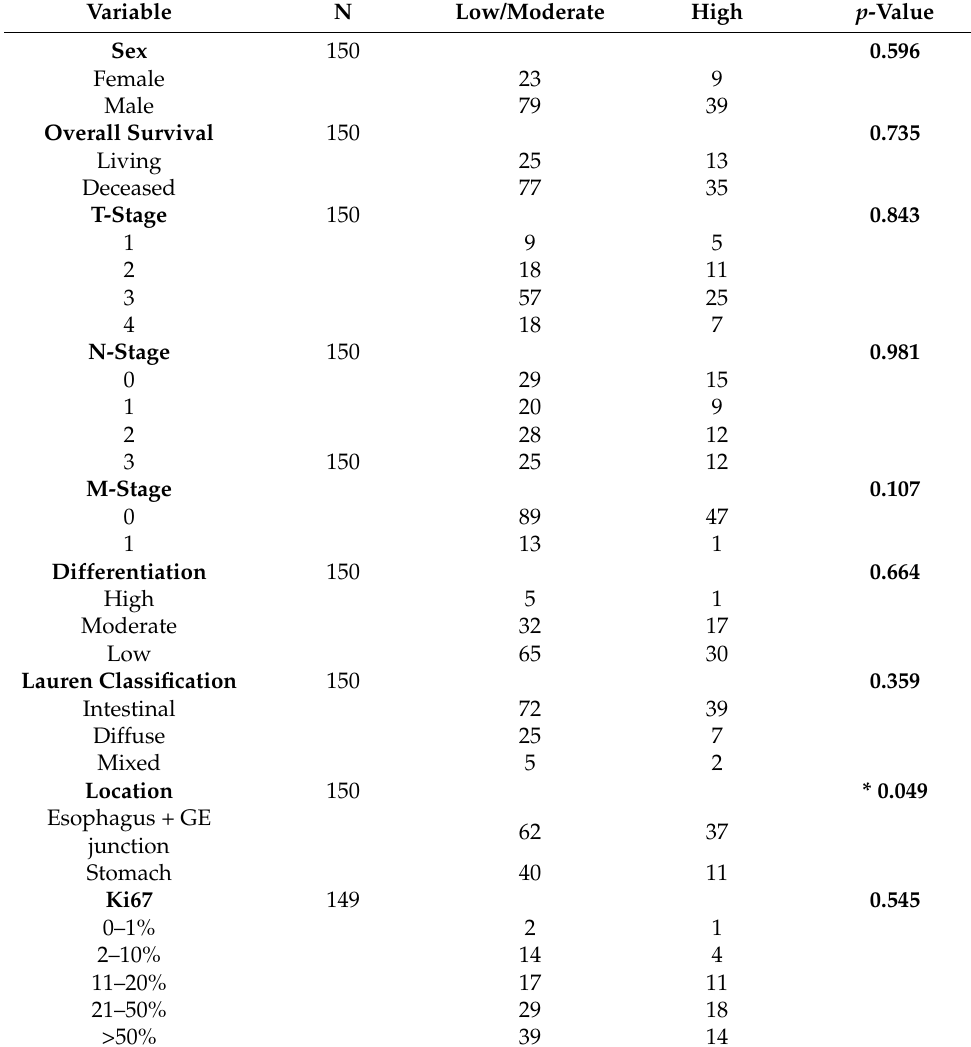
Figure 2. JAM-A immunohistochemical scoring in a GE cancer tissue microarray. JAM-A immunohistochemistry (IHC) was performed on 4 µ m sections across a TMA of GE cancers totaling 174 primary tumor cases with 150 scorable cases (of which 43 had duplicate cores). Membranous JAM-A expression was scored 0, 1+, 2+, 3+ based on completeness and intensity of staining. Scale bar = 200 µ m. Table 1. Associations between JAM-A expression and clinicopathological